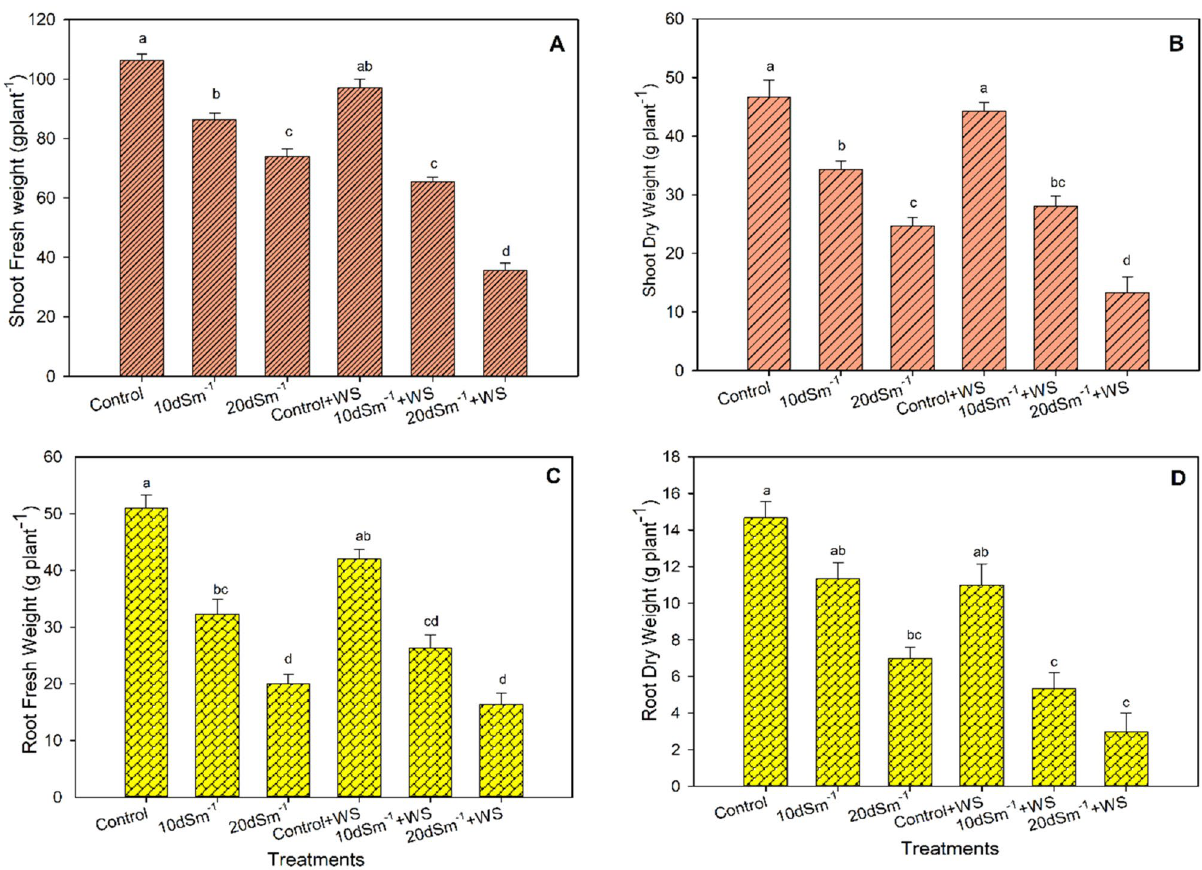
Figure 1. ( A ) Fresh weight and ( B ) dry weight of the shoot, and ( C ) fresh weight and ( D ) dry weight of the root of guava under salinity and water stress treatments. The different letters show significant differences according to the Tukey Honest Significant Difference (HSD) test after ANOVA ( p ≤ 0.05); WS = water stress.